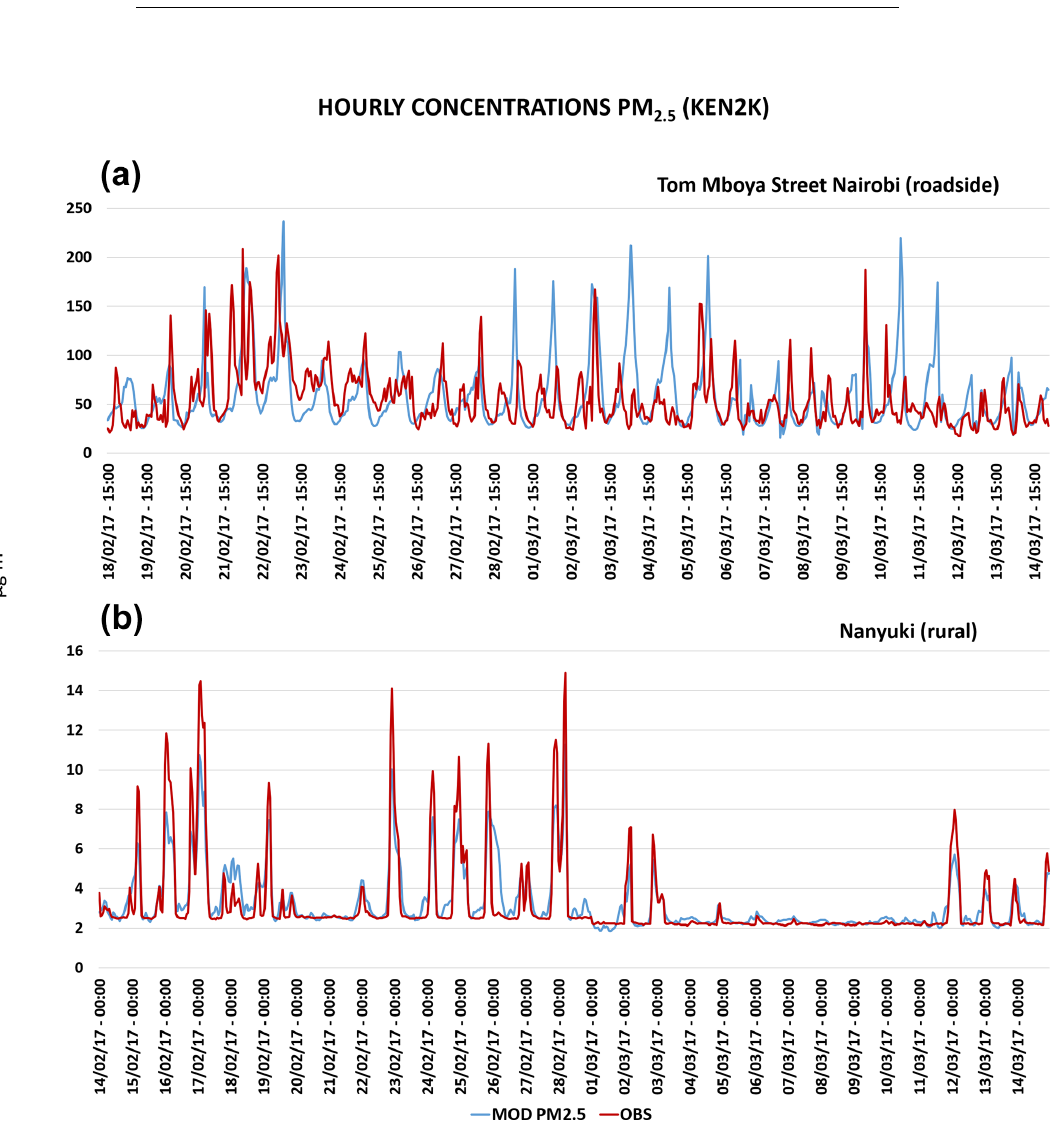
Figure 7. The hourly time series for PM 2 . 5 from (a) the roadside of Tom Mboya Street and (b) the rural site of Nanyuki based on CHIMERE model output (blue line) and observed values from Pope et al. (2018) (red line) for the analysed period The simulation started on 14 February. For the Tom Mboya Street site, only the period of time between 18 February and 14 March (period for which observations are available) is shown in the time